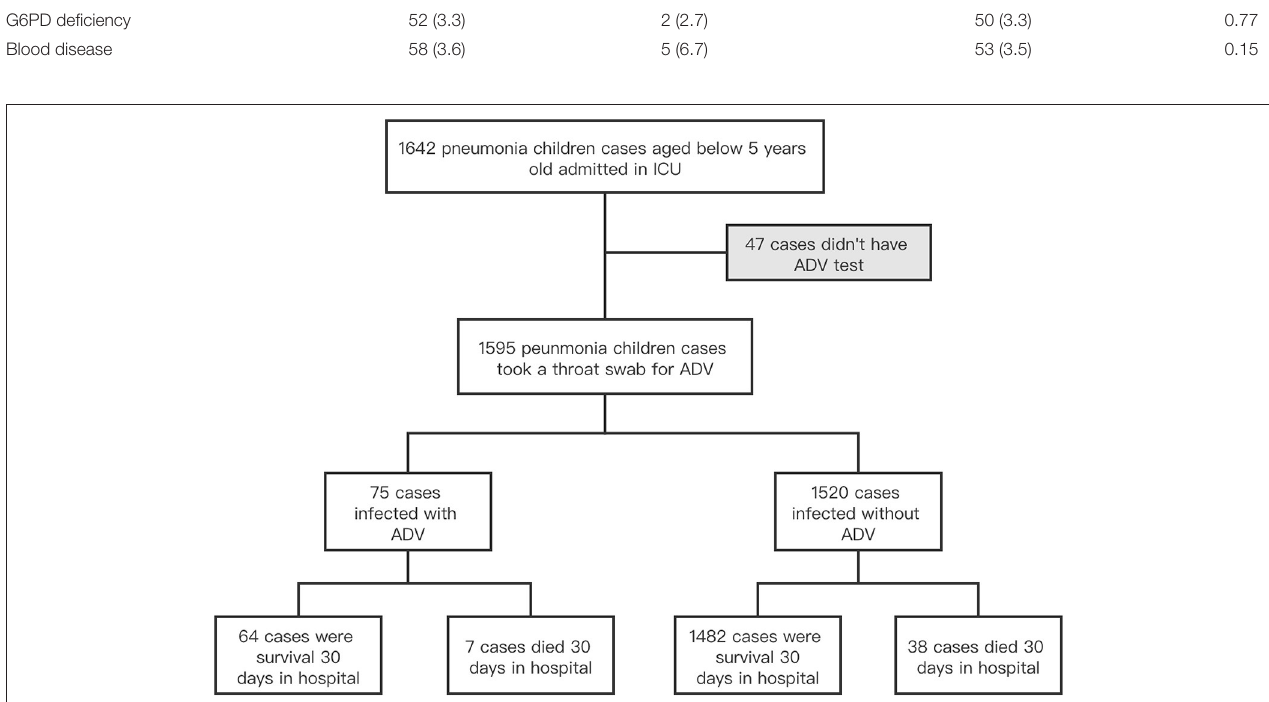
and infected with a combination of other microorganisms, but less likely to have mixed virus infection and co-occurring cardiovascular disease than cases without adenovirus infection ( Table 1